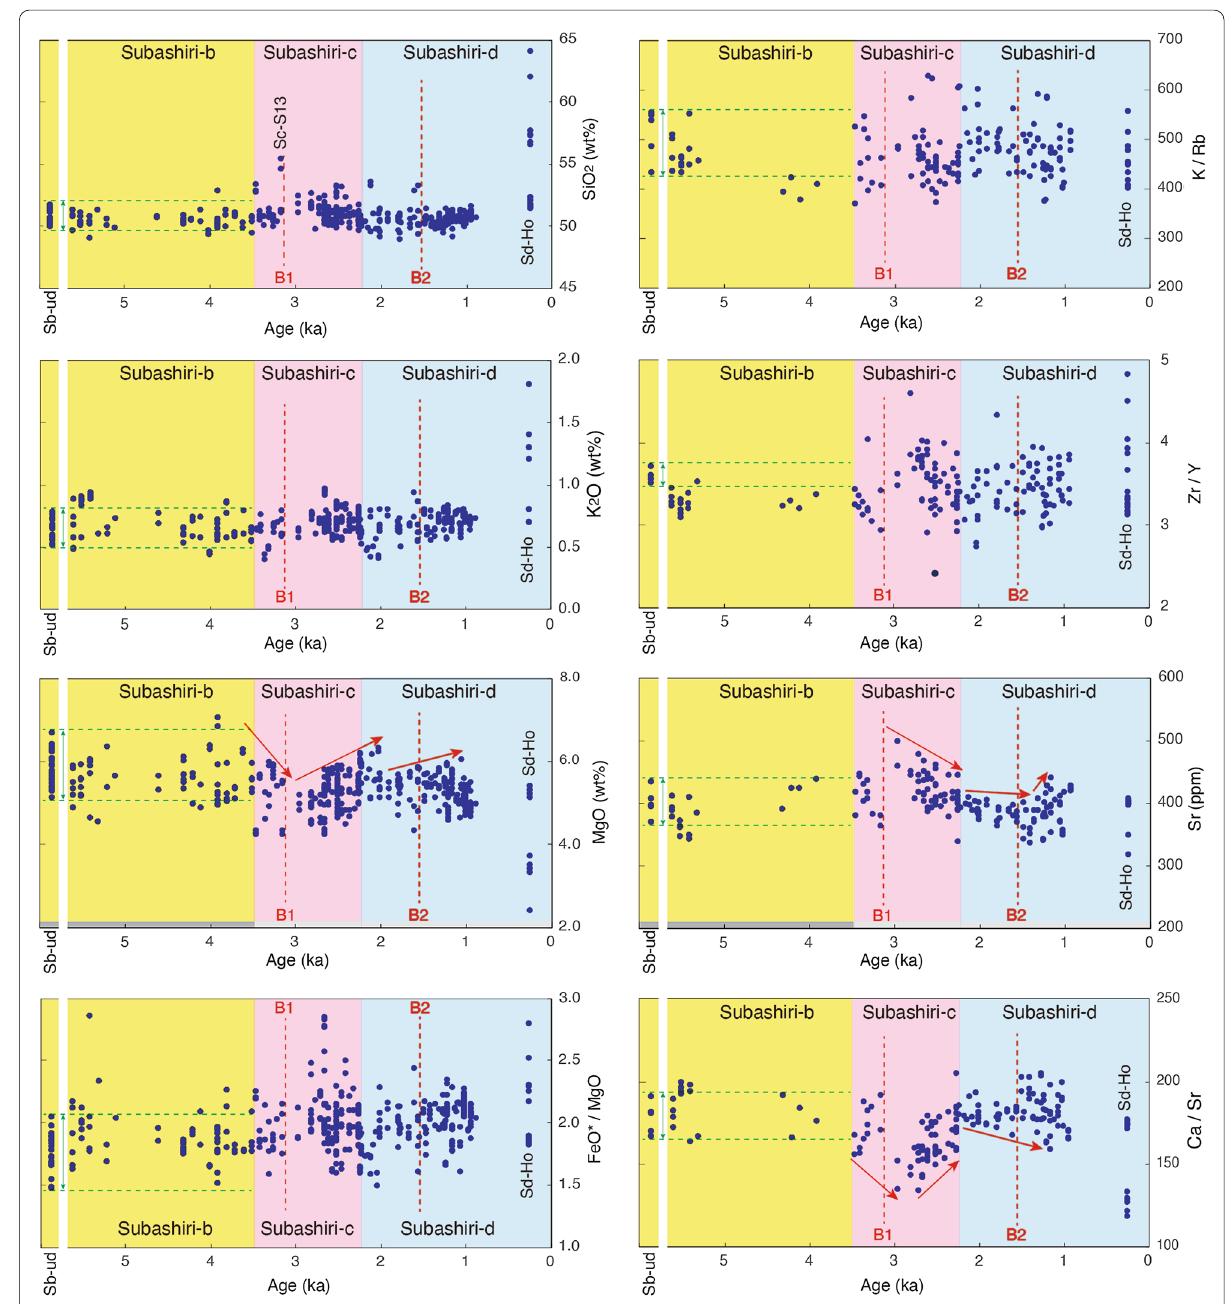
Fig. 3 Temporal variations of the geochemistry of eruptive products since 5.6 ka. Green dashed lines indicate the geochemical range of the Subashiri-b stage edifice (Sb-ud). B1 and B2 are bending ages of the eruption rate in Fig. 2. Sc-S13 Hoei